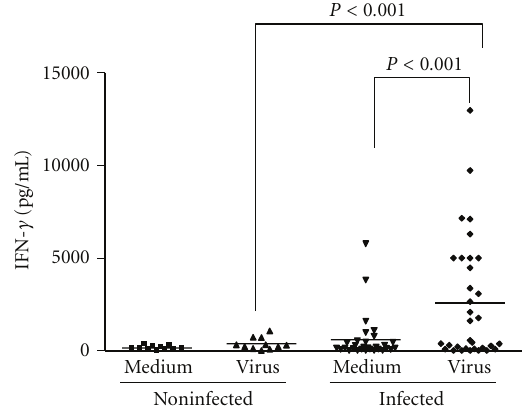
Figure 3: Interferon-gamma production in PBMCs of individuals infected or not by zoonotic Vaccinia virus. Peripheral blood mono- nuclear cells (PBMCs) from patients infected or not with zoonotic Vaccinia virus were cultured in the presence of UV-inactivated virus or mock-treated (medium). After 6 days of stimulus, the amount of IFN- γ produced in the cultures’ supernatants was measured by cytometric bead array immunoassay. Statistical significance ( P values), based on the median values of each group, is